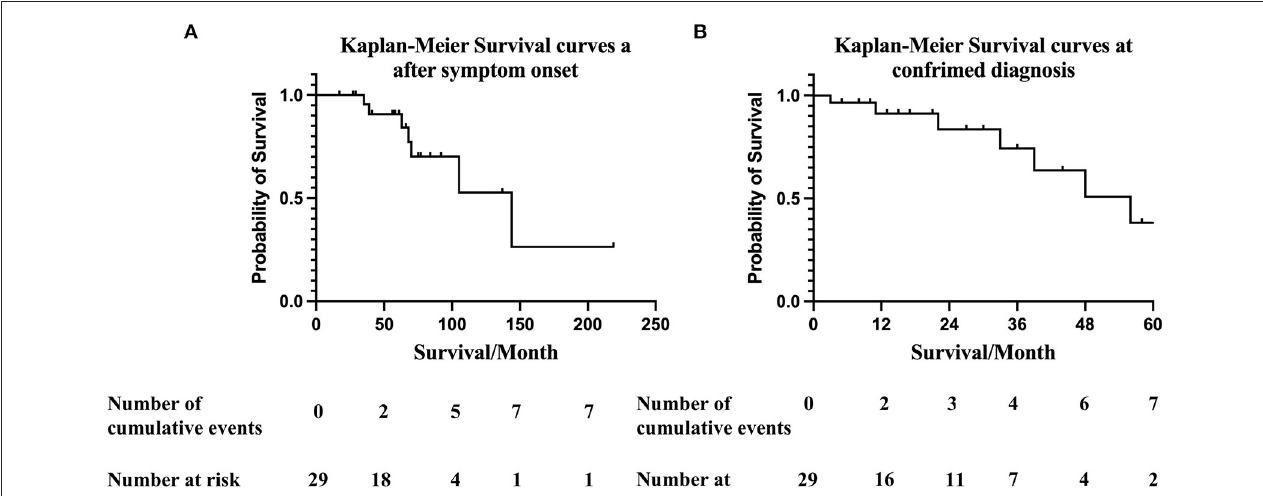
FIGURE 2 | (A) Kaplan-Meier survival curves of data obtained from ATTR-CA symptom onset. Overall survival at 12-, 36-, 60-, and 120- months after symptom onset were 100%, 90%, 70% and 52.6%, respectively. Numbers below the plot represent the number of subjects at risk at each time point. Cumulative events refer to all-cause death. The median survival time after symptom onset was 131 (95%CI 88.6–173.7) months. (B) Kaplan-Meier survival curves at confirmed diagnosis. Overall survival at 12-, 36-, and 60- months was 91.2%, 74%, and 38% respectively. Numbers below the plot represent the number of subjects at risk at each time point. Cumulative events refer to all-cause death. The estimated median survival time after confirmed diagnosis of ATTRv-CM was 47.6 (95%CI 37.9–57.4) months.